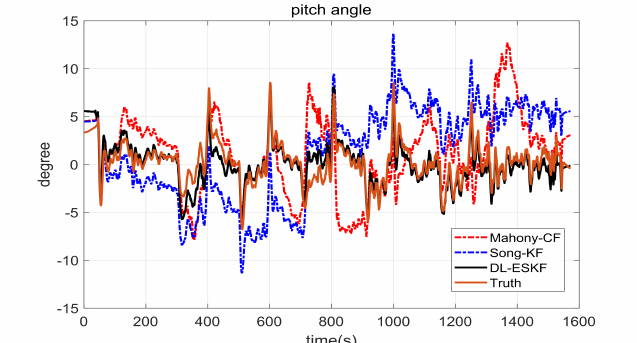
Figure 16. Pitch angle under dynamic conditions.